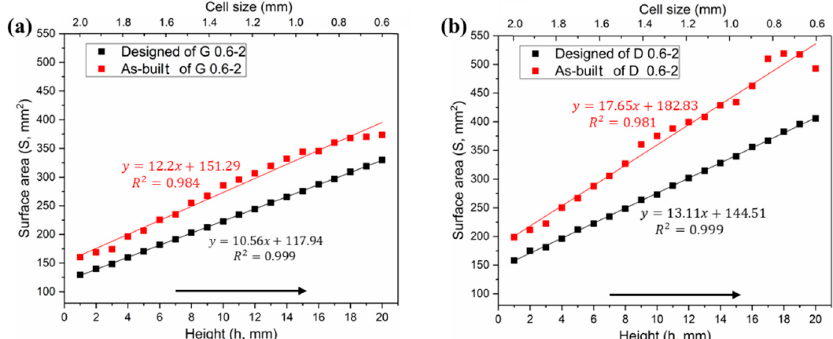
Figure 5. Comparative analysis of surface area distributions between designed and as-built models, ( a ) Gyroid gradient porous structure, and ( b ) Diamond gradient porous structure.